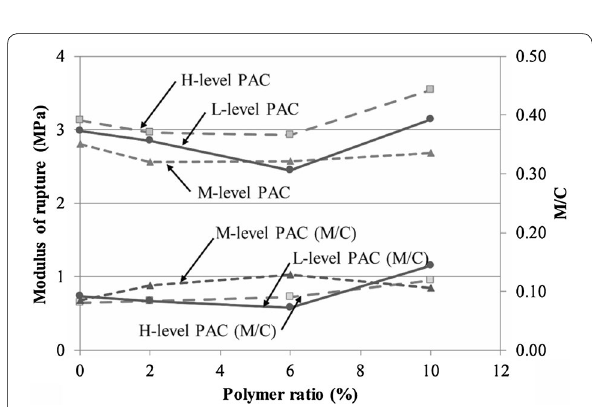
Fig. 18 Tensile strengths and tensile-to-compressive strength (M/C) ratios.